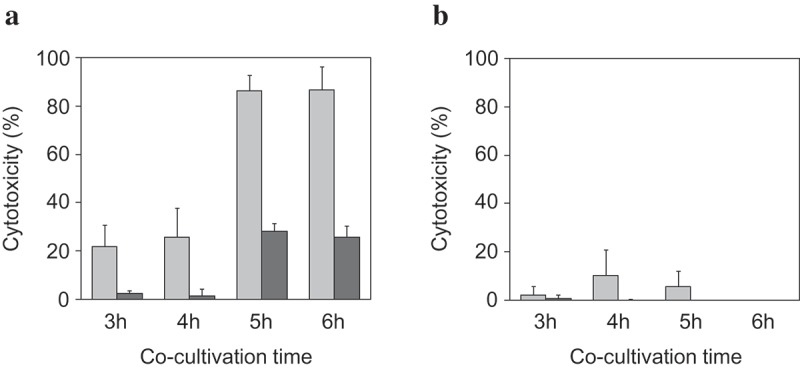
The time-dependent cytotoxicity of the SLS from β-hemolytic SAA against HSC-2. HSC-2 was co-cultivated with β-hemolytic S. anginosus subsp. anginosus NCTC10713T(a) or the non-hemolytic sagA1 and sagA2 double deletion strain of NCTC10713T (ΔsagAs) (b). The time-dependent cytotoxicity was evaluated using the CellToxTM green cytotoxicity assay (light-gray bar) and CytoTox-ONETM homogeneous membrane integrity assay (dark-gray bar) from 3 h to 6 h co-cultivation. The results are shown as the percentage of cytotoxicity with standard deviation (SD) to 0% viable control (n = 3).